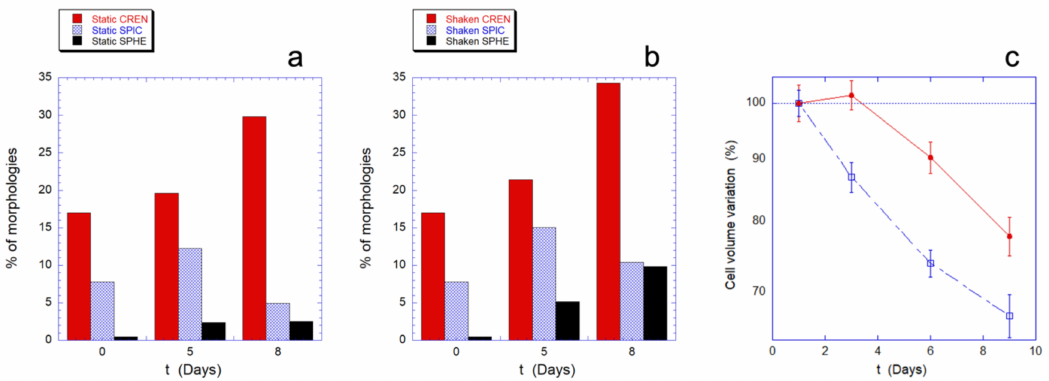
Figure 5. Morphological evolution and volume variation as a function of the RBC aging. Panels ( a , b ) show the morphological evolution in absence ( a ) or presence ( b ) of mechanical stimulation. The red, light blue, and black columns represent the percentage of altered, non-biconcave, shapes observed in the samples. The data arise from a count of at least 1000 cells per sample performed with a conventional optical microscope. Therefore, these analyses do not have enough sensitivity on the nanoscale to appreciate the details of the cell membrane but these data allow the analysis of a statistically significant dataset composed of a high number of cells. Panel ( c ) shows the decreasing trend of the mean cell volume, as measured using AFM imaging, for static controls (red circle) and mechanically stimulated cells (open square) as function of the aging. It is worth noting that, for experimental reasons, the optical and the AFM images were collected on alternating days, in such a way that the comparison between these techniques must be performed in term of the overall observed